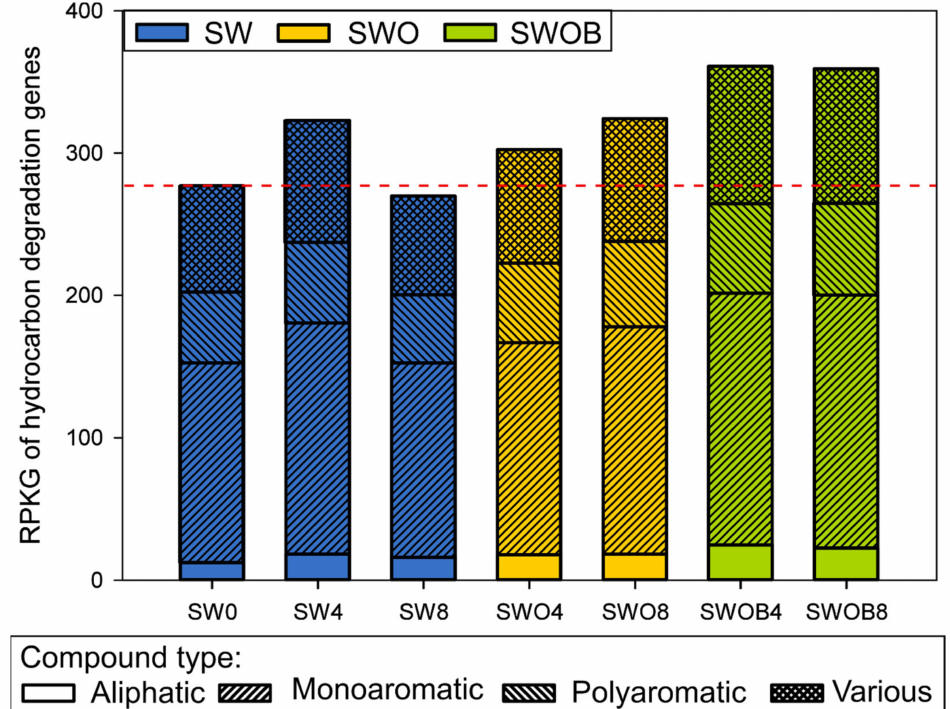
Figure 6. The summarized abundance of detected oil hydrocarbon degradation-related genes, pre- sented as gene-specific reads per kilobase per genome equivalent (RPKG), in microbial communities of seawater (SW), oil-contaminated seawater (SWO), and biostimulated oil-contaminated seawater (SWOB). The numbers in the codes of samples denote incubation time in months. The genes are separated into groups by the compound types whose degradation they are involved in. “Various” means that the gene can be related to degradation pathways of more than one compound